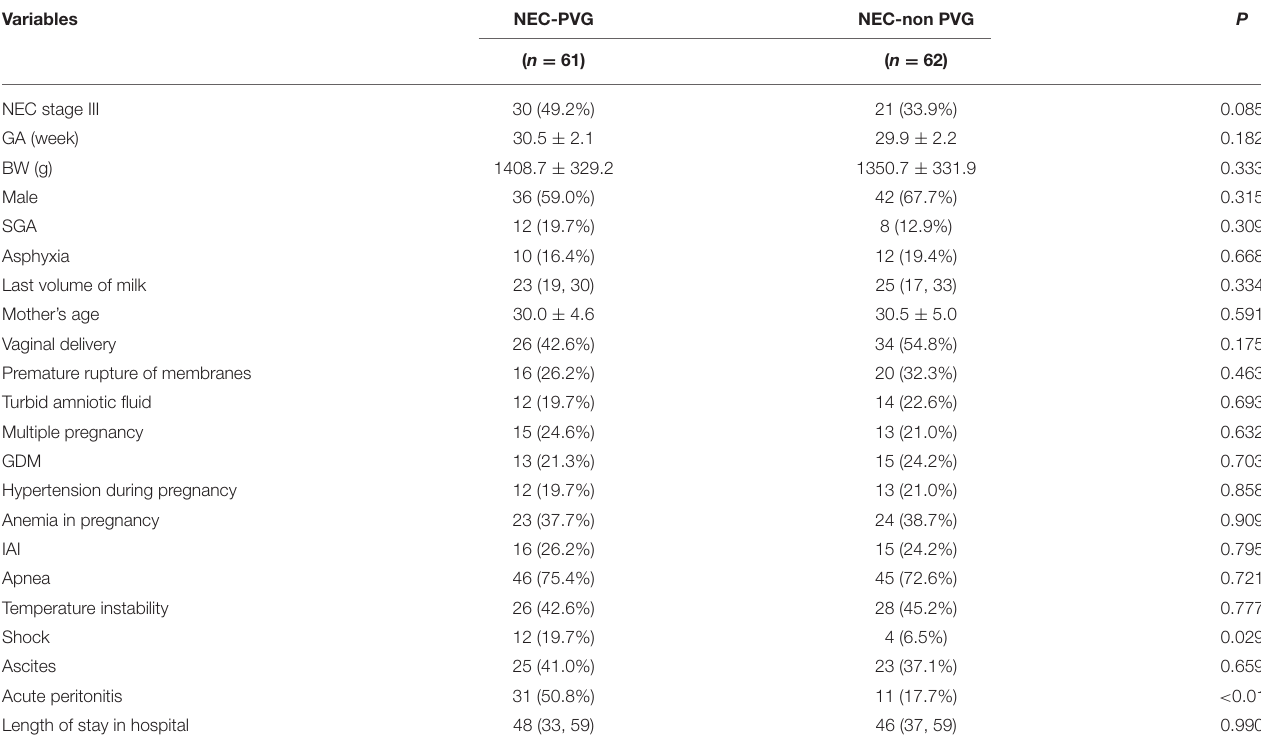
TABLE 1 | The demographic characteristics of NEC-PVG group and NEC-non PVG group.